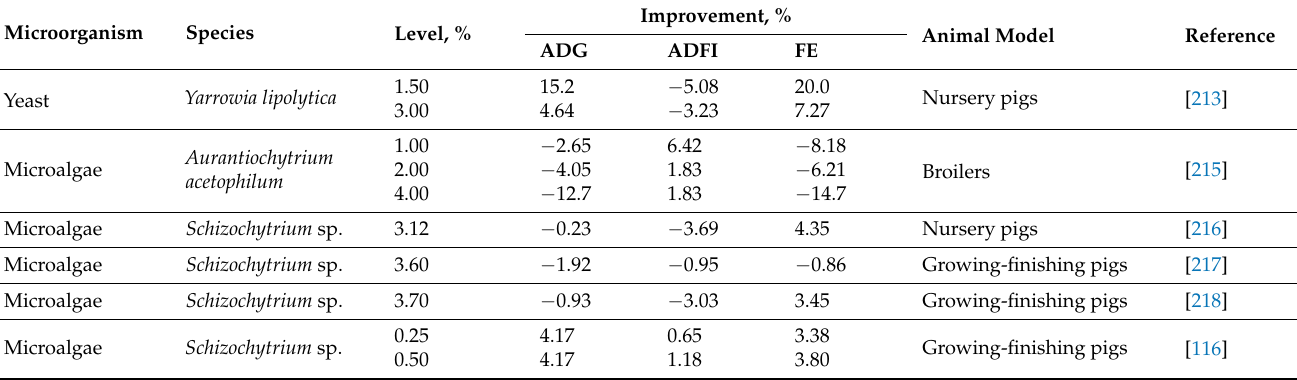
Table 10. Single-cell oils from microorganisms and their impacts on growth